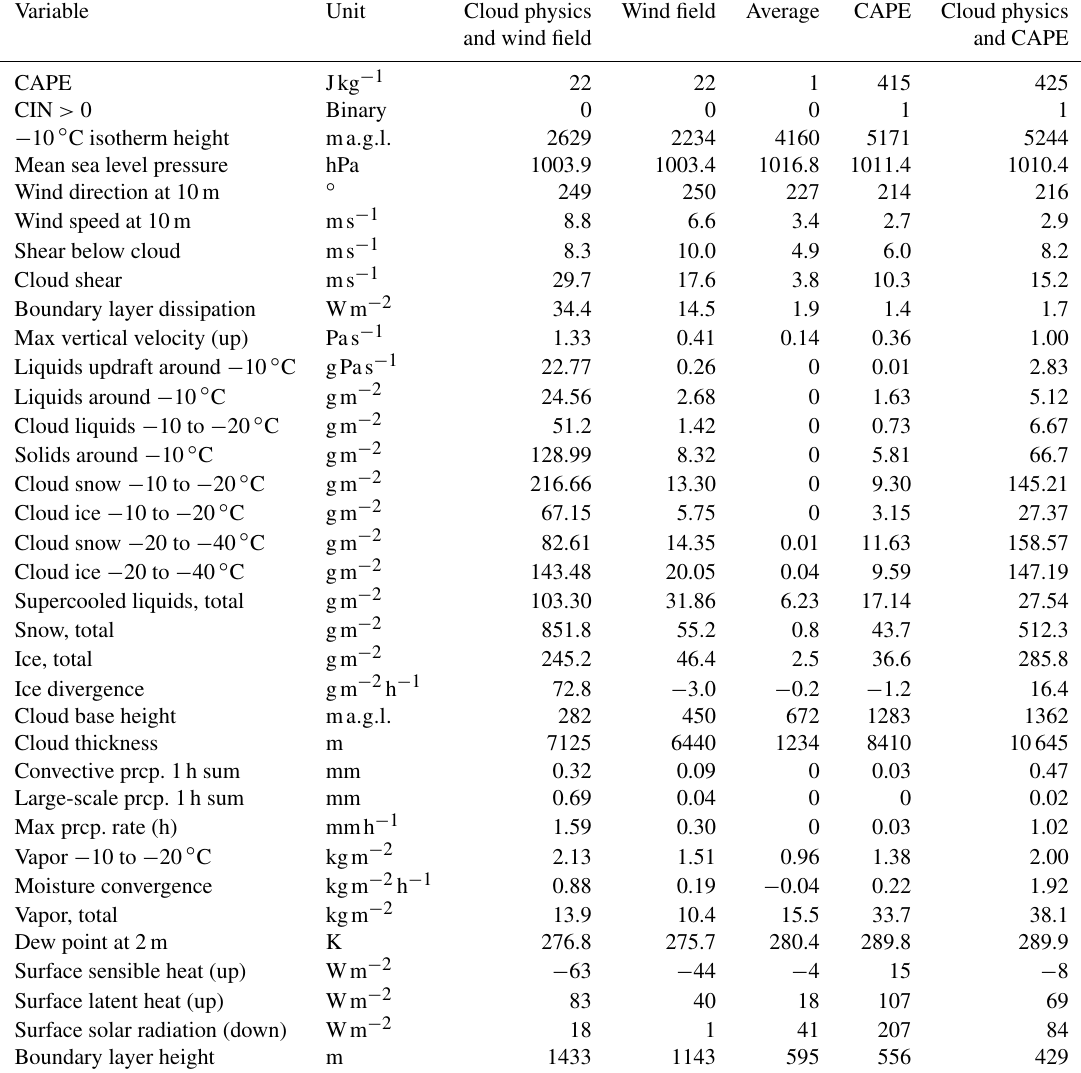
CAPE: convective available potential energy, CIN: convective inhibition, a.g.l.: above ground level, prcp.: